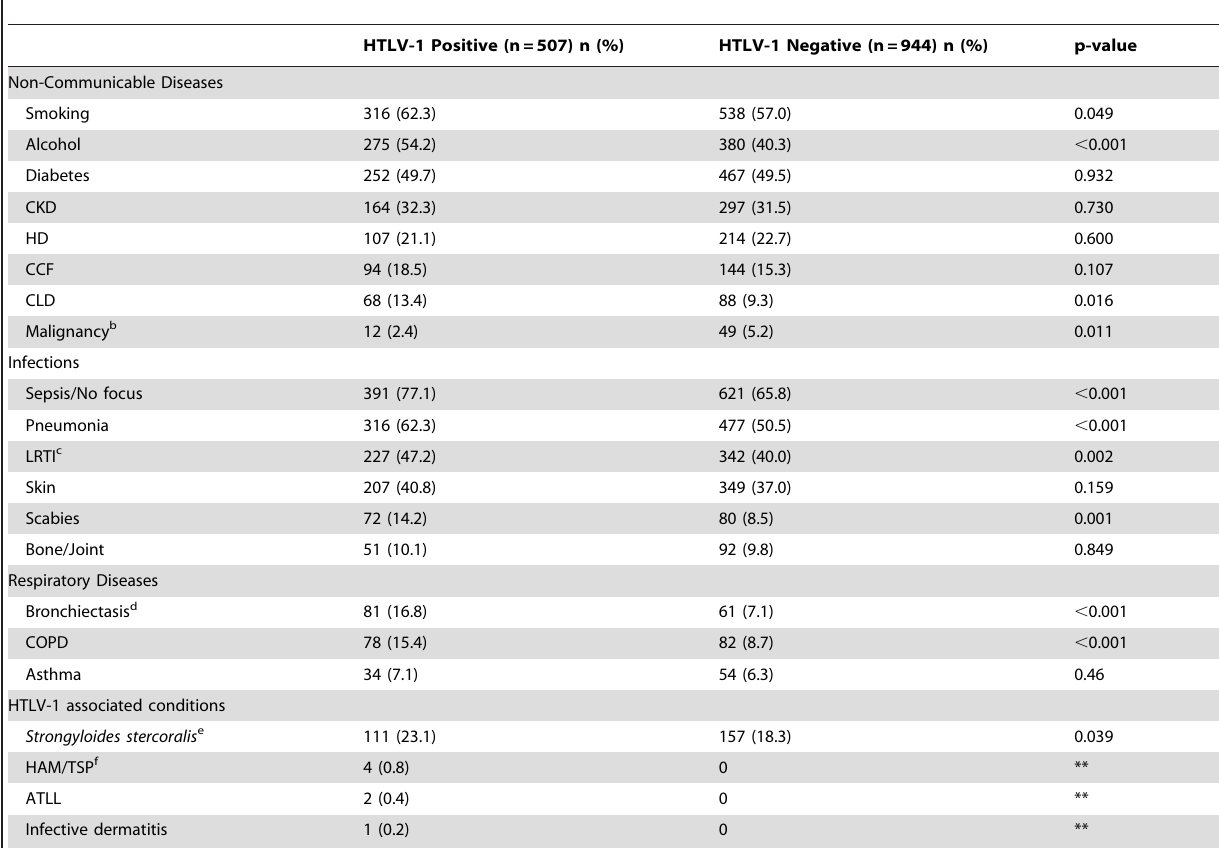
Table 3. Comparison of clinical conditions identified by International Classification of Diseases-10 (Australian Modification) morbidity codes according to HTLV-1 serostatus among 1451 Indigenous adults admitted 2005–2010 a